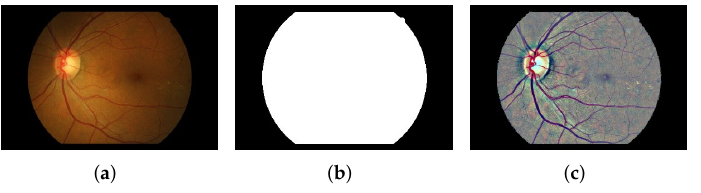
Figure 3. Illustration of the entire procedure for image preprocessing. ( a ) Original resized image. ( b ) Binary mask of the ROI. ( c ) The preprocessed